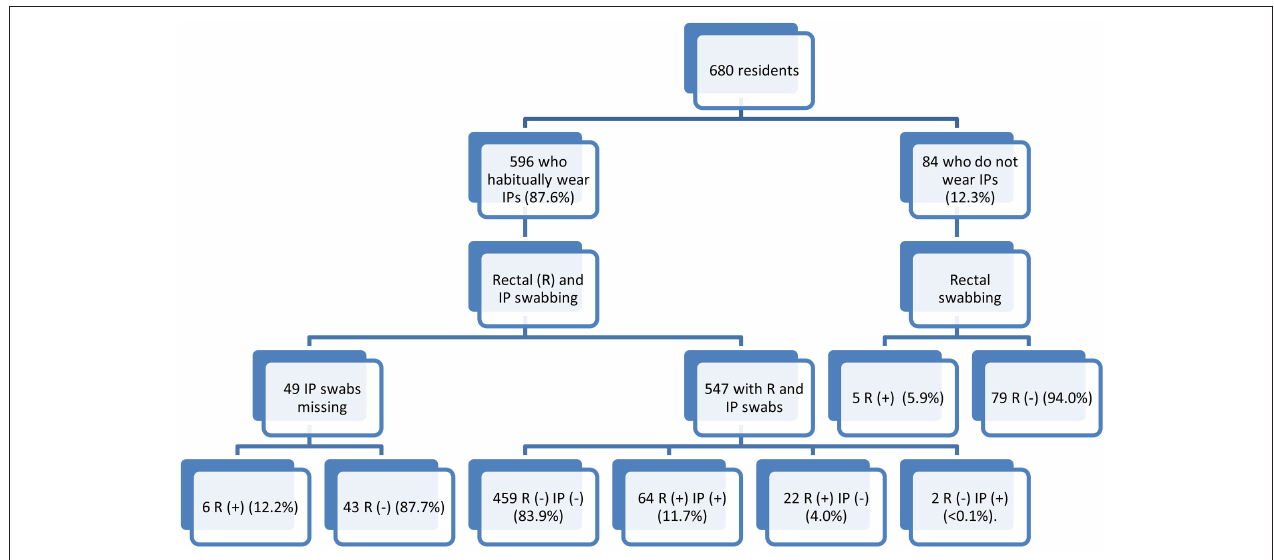
FIGURE 1 | Distribution of positive and negative rectal and IP